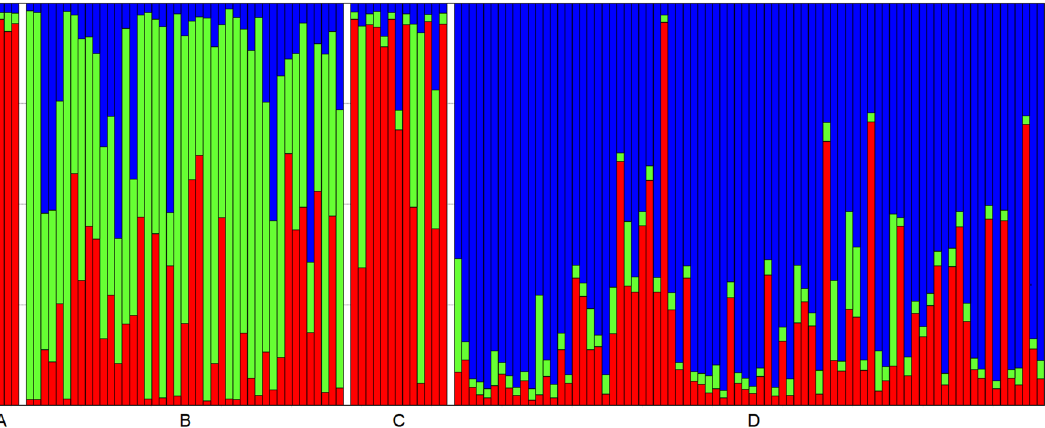
Figure 2. Genetic structure of 141 sweet chestnut multi-locus genotypes (MLG) as estimated by STRU CTU RE at K = 3. Each MLG is represented by a vertical line and each cluster by a different color: Cluster I in red, Cluster II in green, Cluster III in blue. Letters A , B , C and D are as follows: Group A represents marron genotypes M001-M005, Group B non-redundant genotypes in P1, Group C non-redundant genotypes in P2 and Group D non-redundant genotypes in P3.